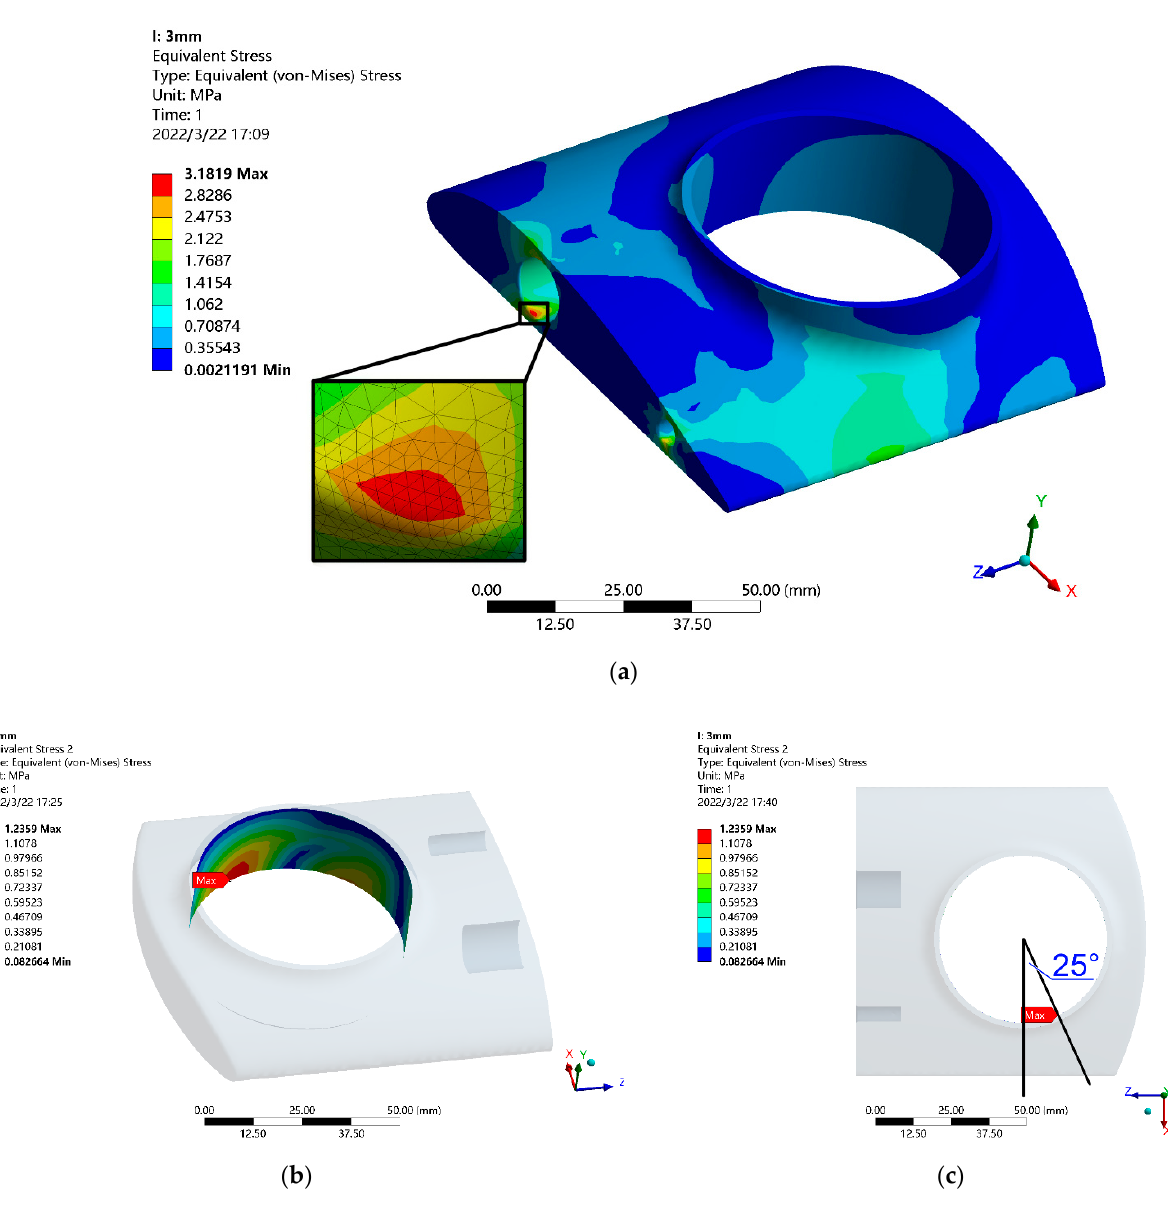
Figure 6. Simulation results. ( a ) Stress simulation results; ( b ) stress of the duct installation hole; ( c ) the relative positions of maximum stress.